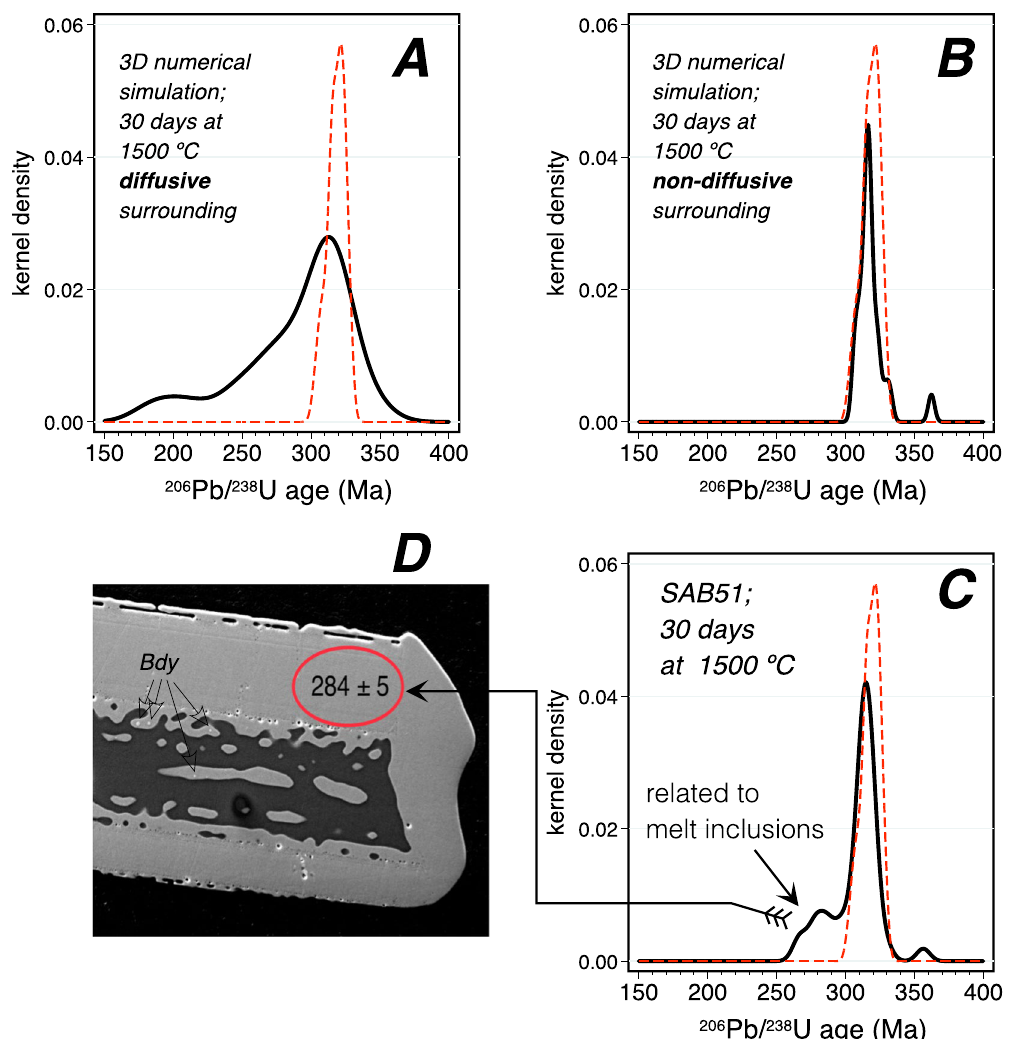
Figure 3. ( A ) Numerical simulation of diffusion in SAB51 at 1500 °C over 30 days in a diffusive surrounding. ( B ) idem in a non-diffusive surrounding. ( C ) Age distribution in the experimental run at 1500 °C for 30 days. The red dashed line represents the distribution of the pristine SAB51 zircon grains. Note the excellent match between the experiment and the simulation with non-diffusive surrounding, except for some data that yielded 206 U/ 238 Pb ages between 250 Ma to 300 Ma. These were always found around melt inclusions. ( D ) Secondary electron image of a zircon grain with a large molten albite inclusion. New zircon and some baddeleyite (Bdy) are produced at the zircon melt interface. The red ellipse represents the spot analyzed with the SHRIMP, which showed loss of lead to the inclusion (also see Supplementary